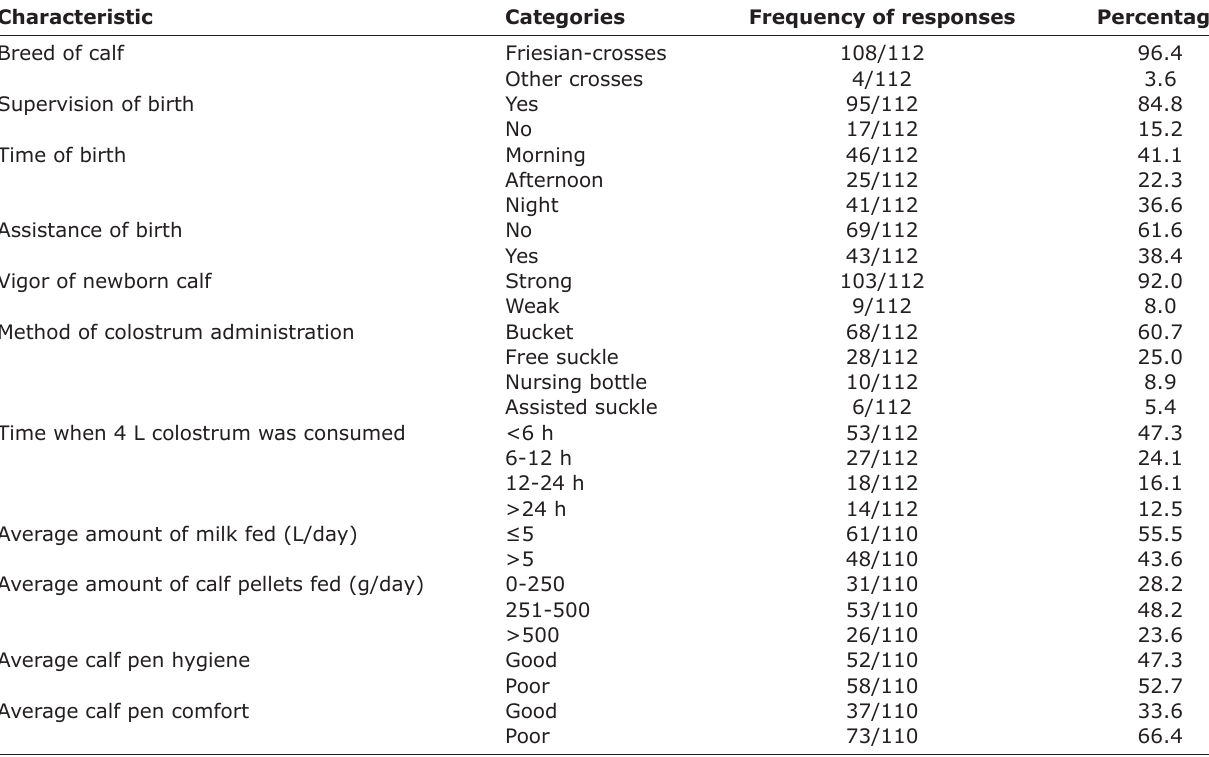
Table-2: Calf management practices for 112 calves in 111 smallholder dairy farms in Mukurwe-ini Sub-County, Kenya. Characteristic